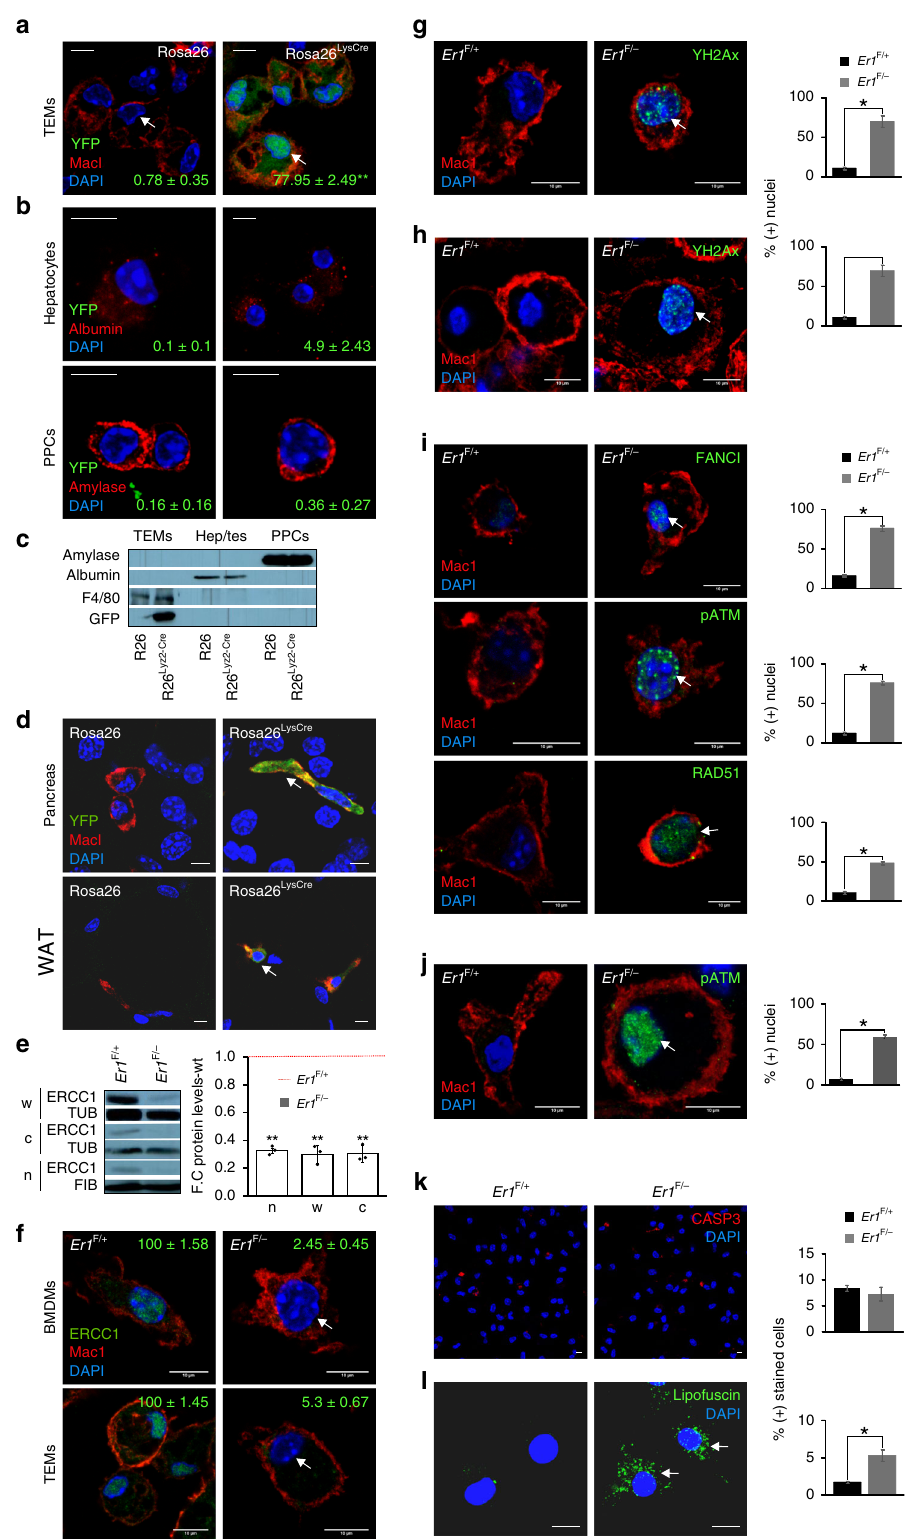
were measured at consecutive time intervals for a period of 3 h. After 2 months on ND, we fi nd no difference in GTT between Er1 F/ − and Er1 F/ + animals (Fig. 3b; as shown). However, we fi nd a progressive difference in GTT between Er1 F/ − and Er1 F/ + animals fed on ND for 4 or 6 months (Fig. 3b; as indicated) that was further pronounced when animals were fed for 4 months